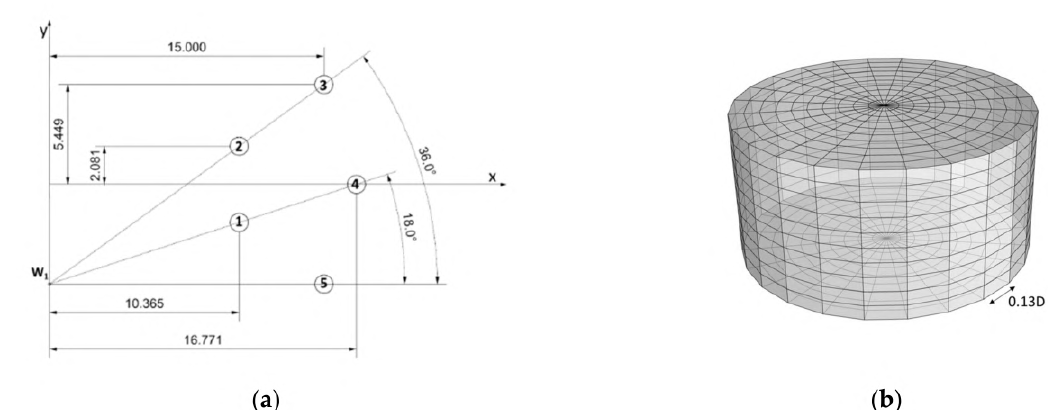
Figure 1. Layout and geometry: ( a ) Positions of the bodies (distance values denote multiples of D); ( b ) WAMIT mesh for each body.